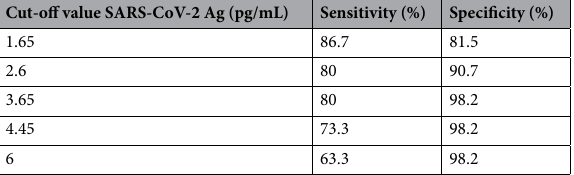
Cut-off value SARS-CoV-2 Ag (pg/mL)